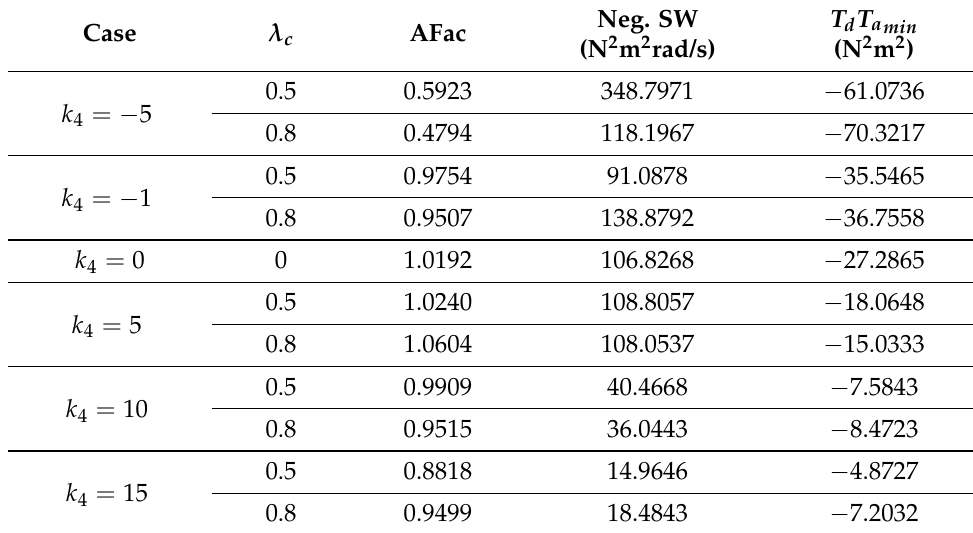
Table 4. Influence of k 4 and λ c on